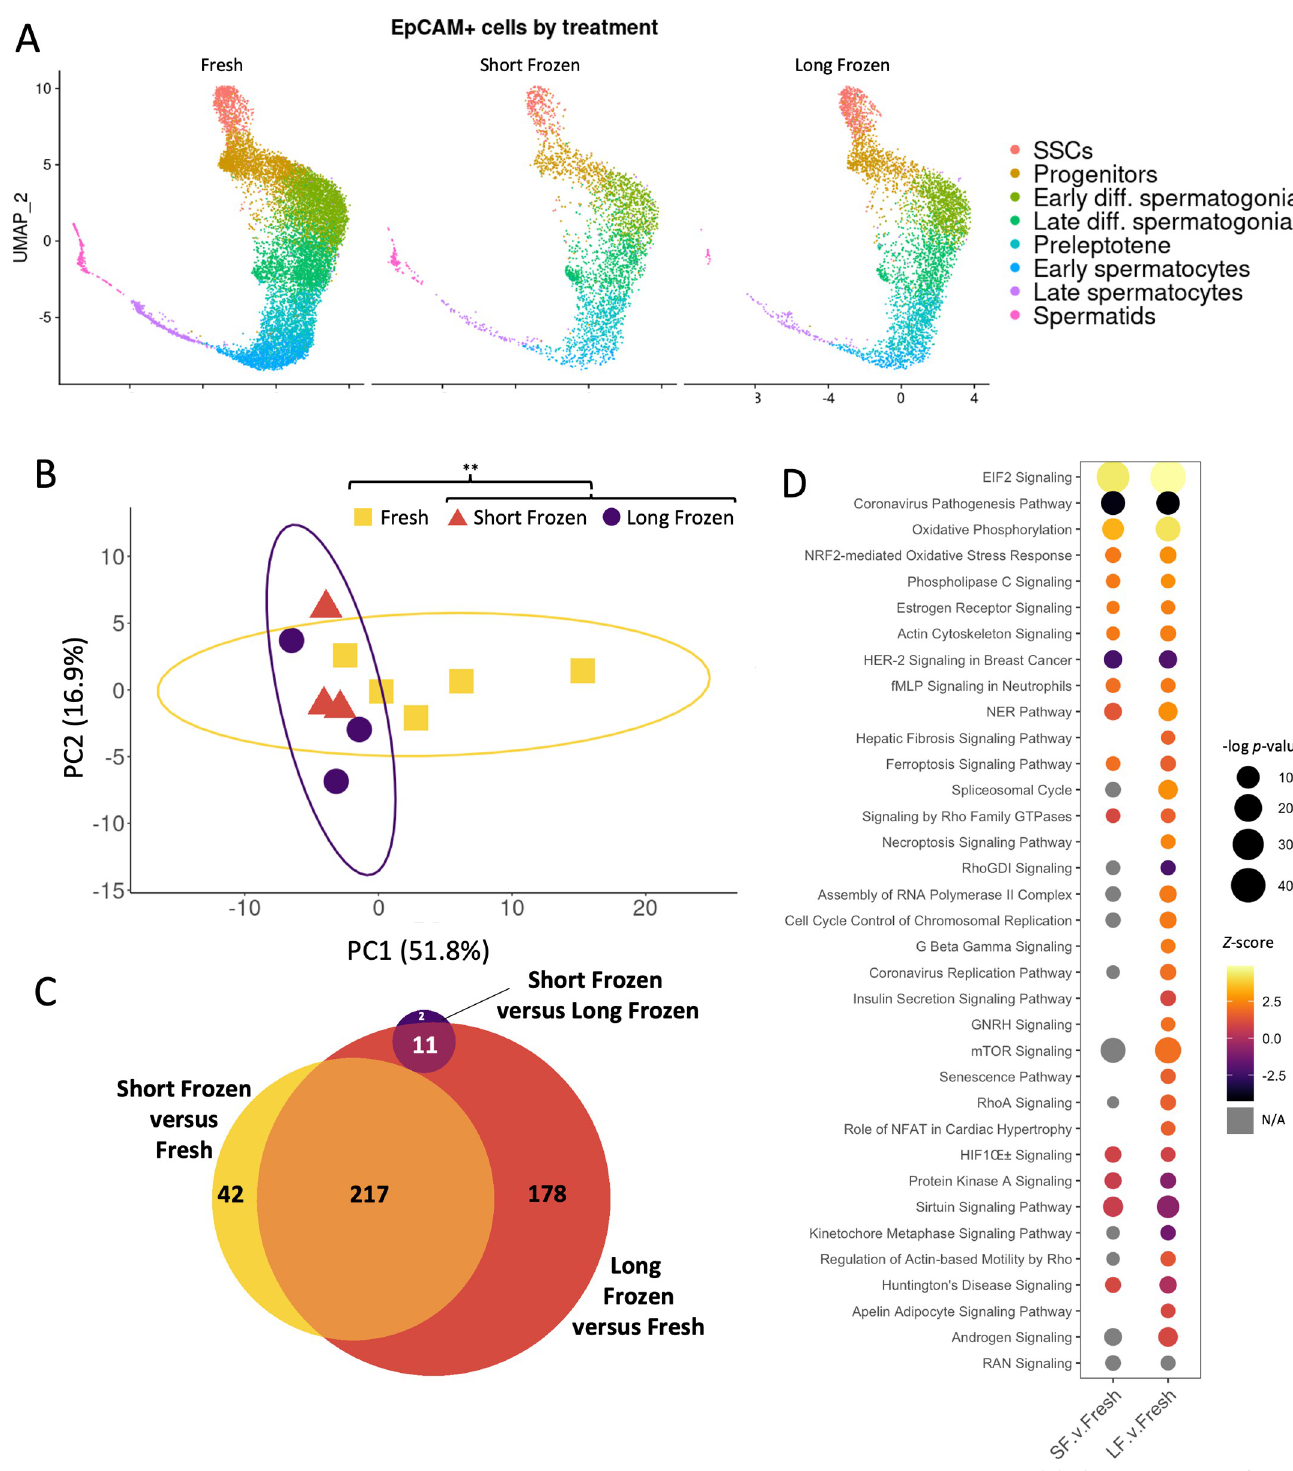
Fig 4. Long-frozen germ cells show similar, but more perturbed, gene expression profiles to short-frozen following thawing. (A) Cluster assignments of germ cells divided by treatment reveals presence of all cell types in each treatment. (B) PCA plot of pseudobulked gene expression data from the SSC cluster. 95% confidence interval ellipses are shown, counting both short- and long-frozen as a single group. Significance assessed by PERMANOVA, 1,000 permutations, pooling short- and long-frozen as a single group, �� p < 0.01. (C) Euler diagram of gene expression difference with minimum 1.5-fold change and false discovery rate < 0.05 cutoffs applied. (D) Ingenuity pathway analysis of DEGs from short-frozen versus fresh and long-frozen versus fresh gene lists. Results ordered by Z -